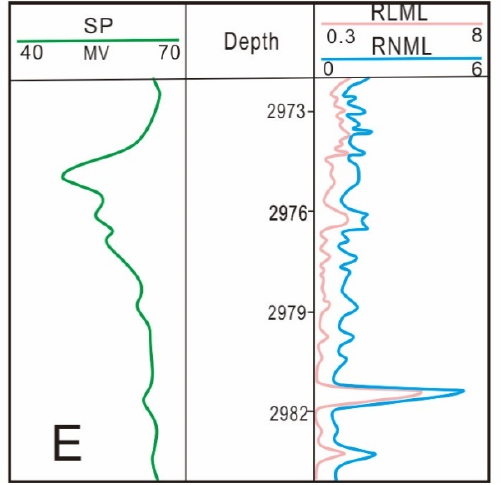
Figure 12. Demonstration curves of natural levee deposits using multiple logs in the study